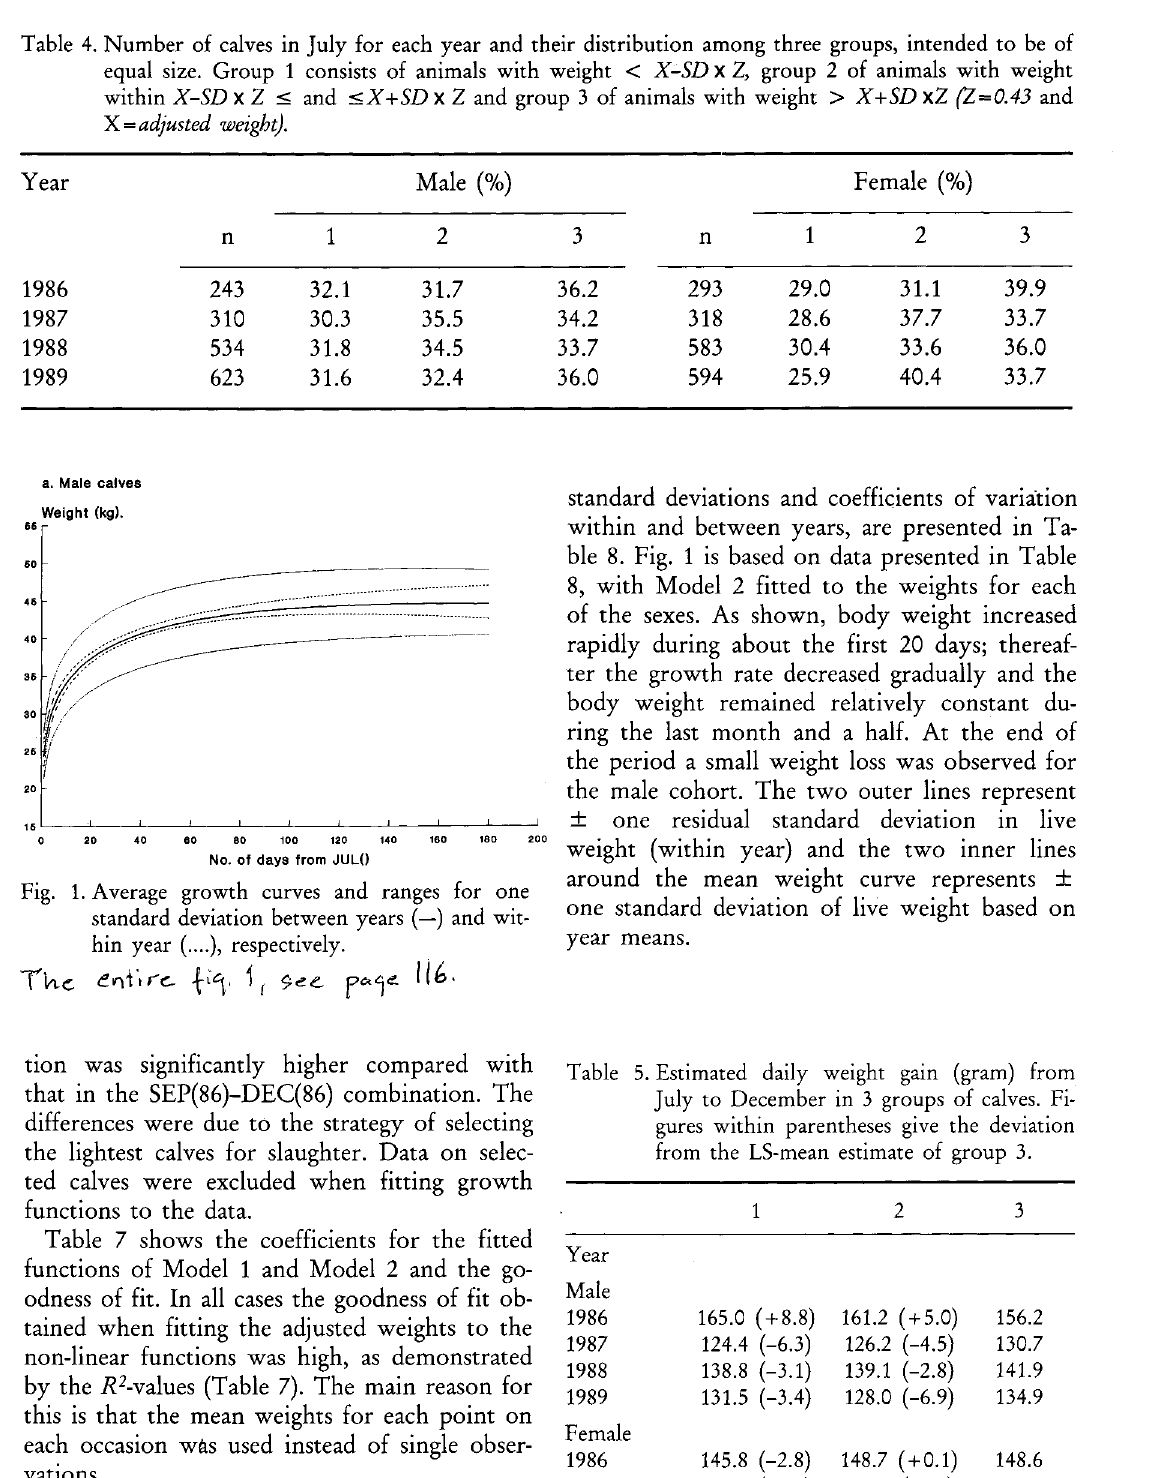
Table 4. Number of calves in July for each year and their distribution among three groups, intended to be of equal size. Group 1 consists of animals with weight < X-SD X 2, group 2 of animals with weight within X-SD X 2 < and <X+SD X 2 and group 3 of animals with weight > X+SD x2 (2=0.43 and X= adjusted weight).